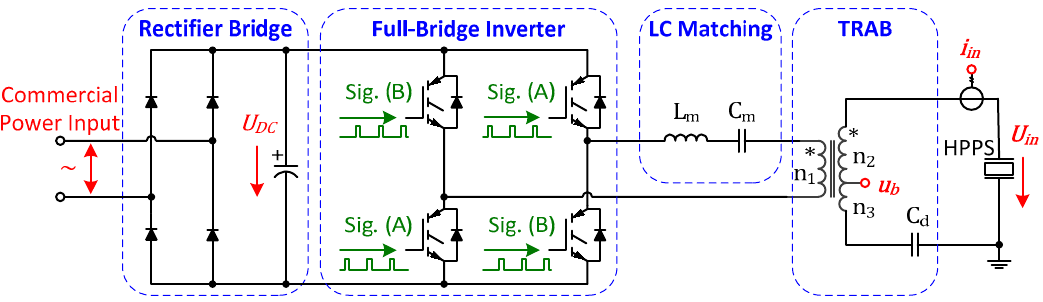
Figure 5. Electrical architecture of the proposed scheme.